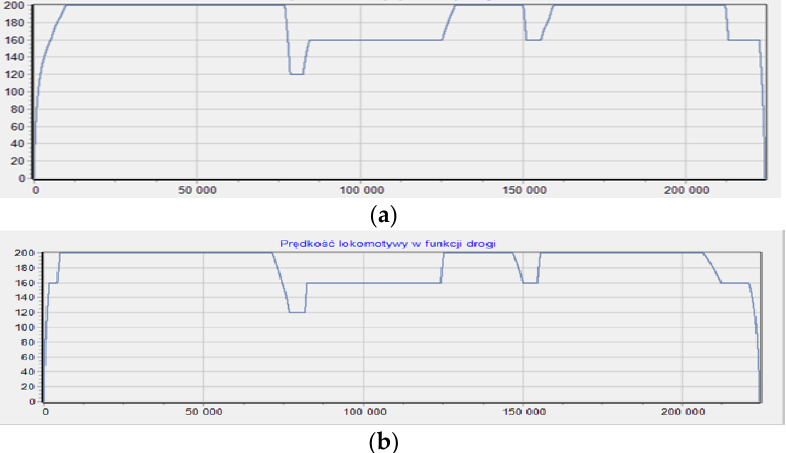
Figure 10. Current drawn by trains on the TI route-direction of movement W-Gd ( a ) ED250 and ( b ) PAS. Source: developed by the authors-results of simulations.